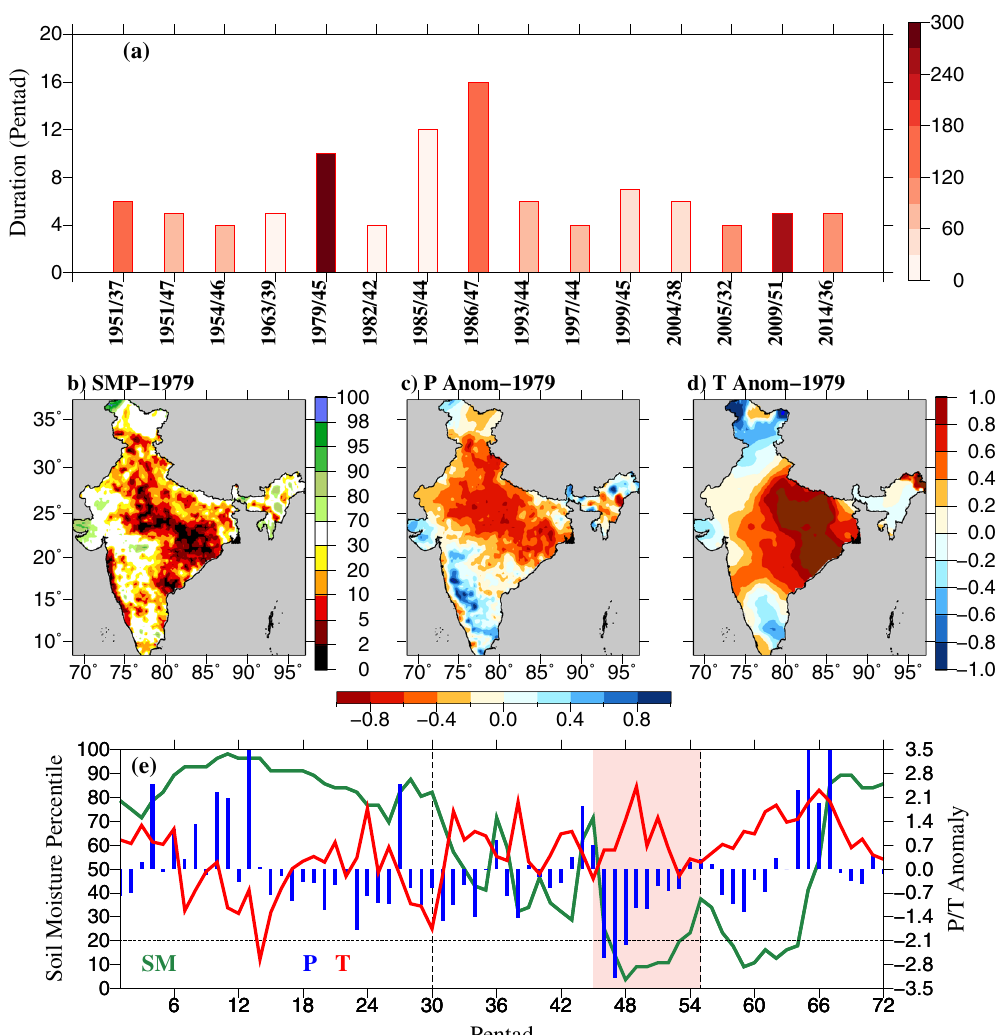
Fig. 1 Flash droughts in the observed climate in India during 1951 – 2016. a Duration and overall severity score (color scale) of fl ash droughts in India, b Soil moisture percentile of 1979 fl ash drought during its peak intensity, c mean precipitation anomaly during the 1979 fl ash drought, d mean temperature anomaly during 1979 fl ash drought, and e evolution of the 1979 fl ash drought in India shown using soil moisture percentile and precipitation/temperature anomalies. Shaded pink region in e shows the duration of the 1979 fl ash drought. Vertical dotted black lines in e show the summer monsoon season (30th to 55th